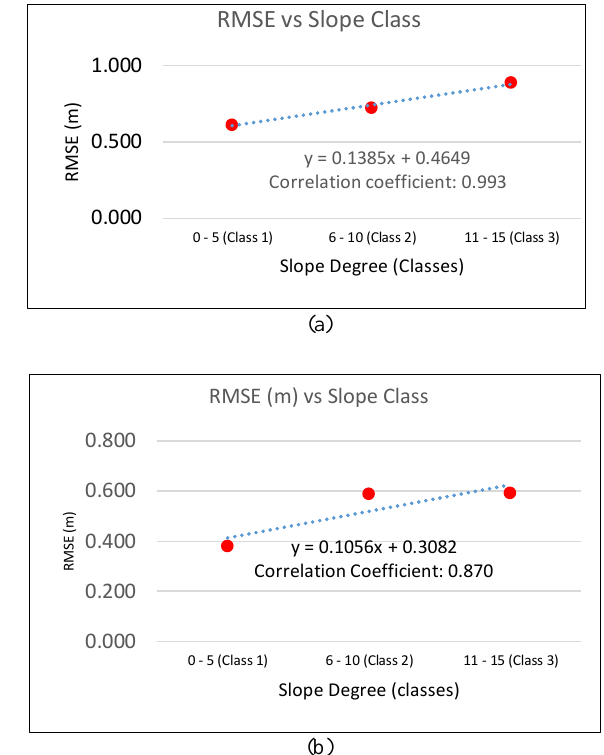
Figure 10. Graph for error of LiDAR-derived DTM associated with terrain slope over (a) rubber trees area, and (b) mixed-forest